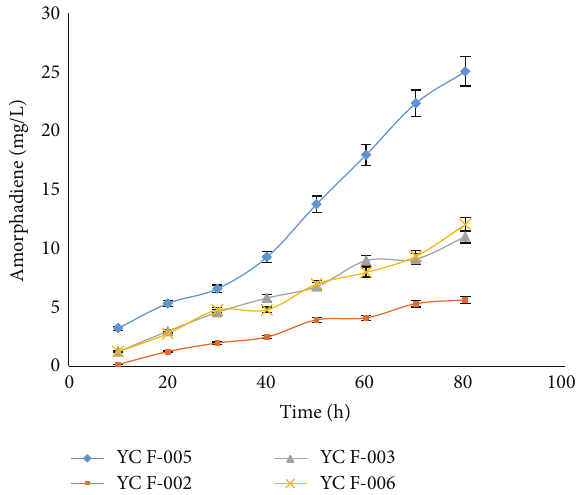
Figure 4: Amorphadiene concentration as a function of time in repressed (YCF-002, YCF-005, YCF-006) and nonrepressed (YCF- AD) yeast strains expression free enzymes ( ADS ) and chimera enzymes ( FPPS-ADS and ADS-FPPS ) (average data obtained from triplicate of the experiments were represented).